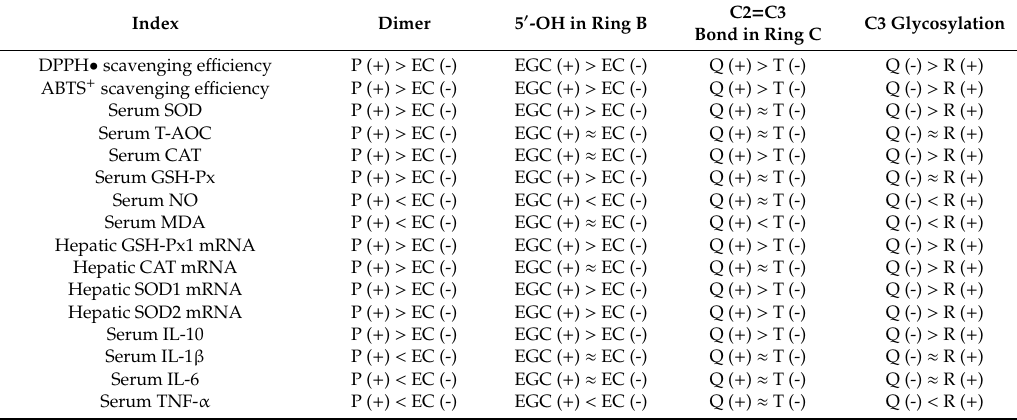
Table 3. The di ff erent e ffi ciencies of the six flavonoids on all the in vivo and in vitro tests. EC, epicatechin group; EGC, epigallocatechin group; P, procyanidin B2 group; Q, quercetin group; T, taxifolin group; R, rutin group. The symbol “ > ” means the level of the former is higher than the latter in the corresponding test; The symbol “ < ” means the level of the former is less than the latter in the corresponding test; The symbol “ ≈ ” means there is no significant di ff erence between the former and the latter in the corresponding test; The symbol “ + “means the corresponding structure exists in flavonoid; The symbol “-” means the corresponding flavonoid is absent in flavonoid. Dimer 5 (cid:48) -OH in Ring